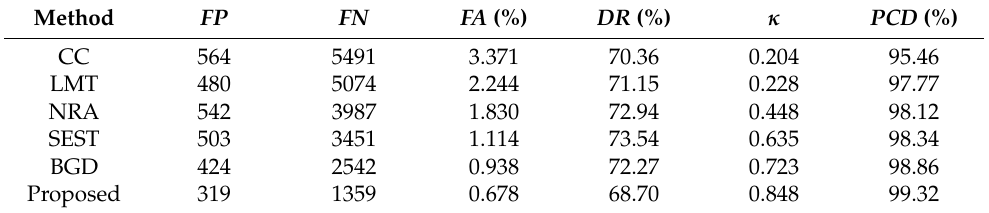
Table 4. Comparison of results from all the six methods using dataset 1 after median filtering.